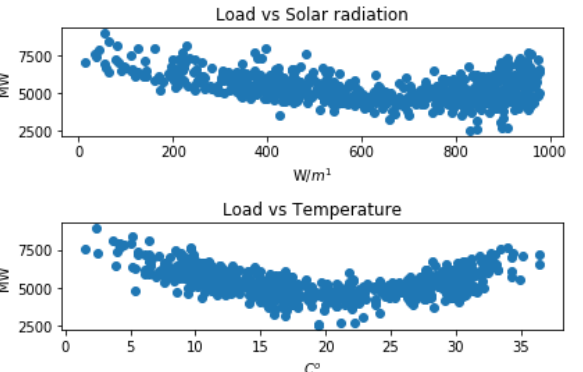
Figure 4. Average daily profile in hourly resolution of load (blue) and standard deviation (shaded) of Greek System Load for one month of observations.